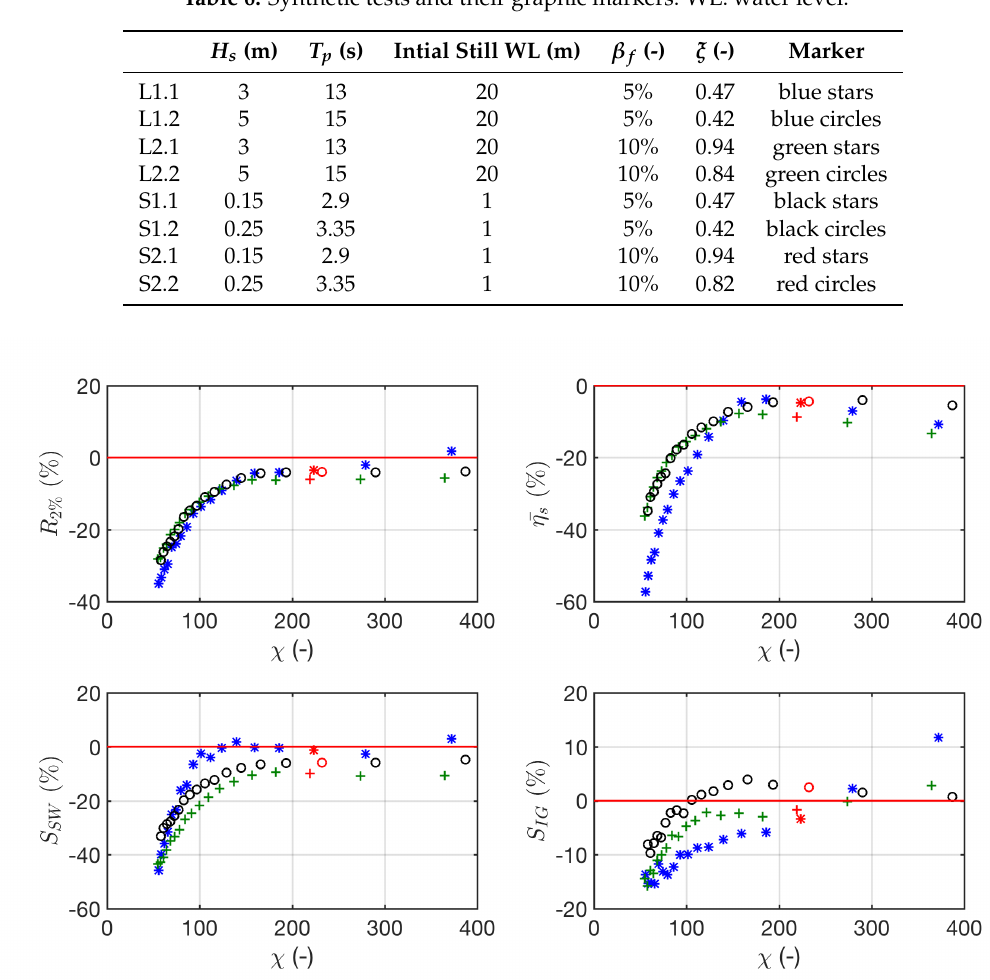
Table 6. Synthetic tests and their graphic markers. WL: water level.